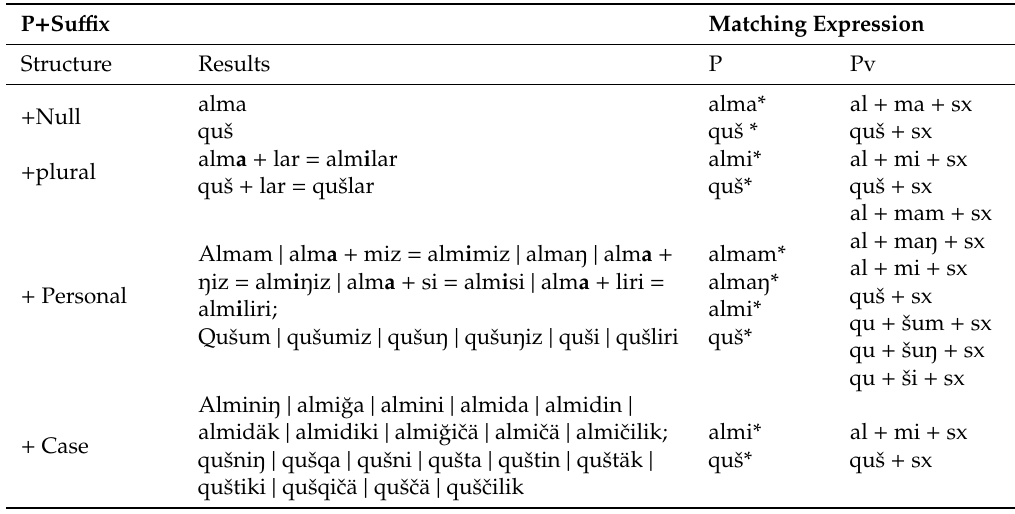
Table 4. Morphological changes of stem with su ffi